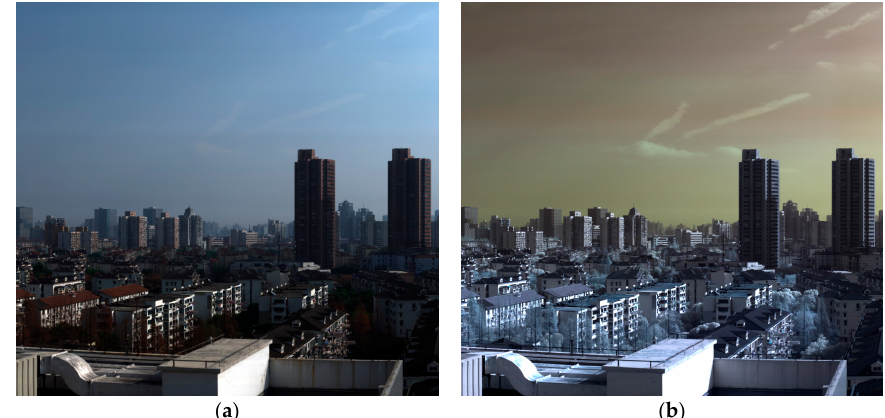
Figure 18. Comparison between the original spectra and the spectra corrected using the flat-field method. ( a ) Ceramic and wall; ( b ) sky and poster.